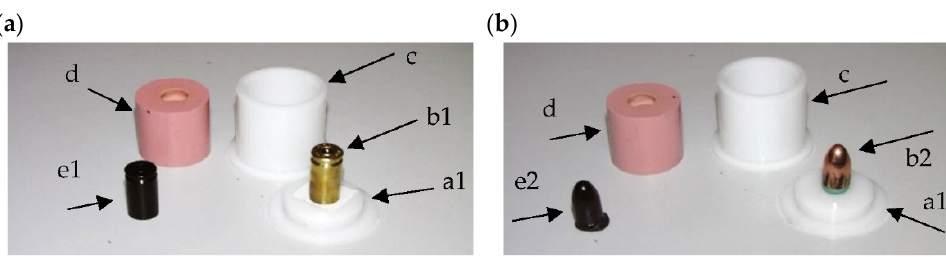
Figure 3. View of the casting molds with cartridge case ( a ) and bullet ( b ) used for testing. Image present the molding box ( c ), parting surface ( a1 ), with the position of cartridge case ( b1 ), bullet ( b2 ), molds ( d ), and cast replicas ( e1 , e2 ).